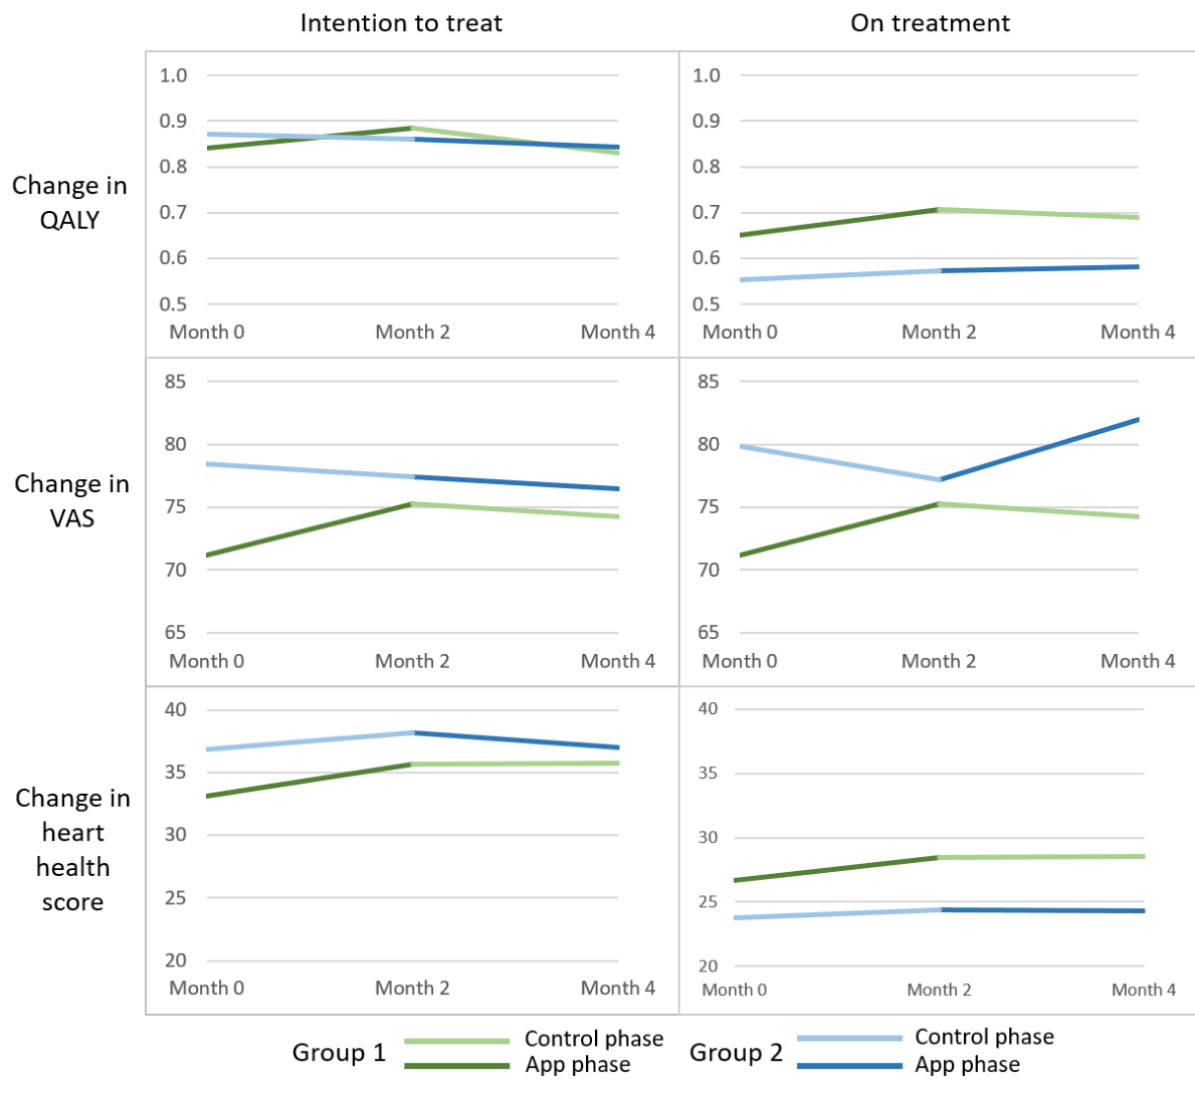
Figure 12. Changes in various assessments of quality of life across different phases of the study. QALY: quality-adjusted life years; VAS: visual analog